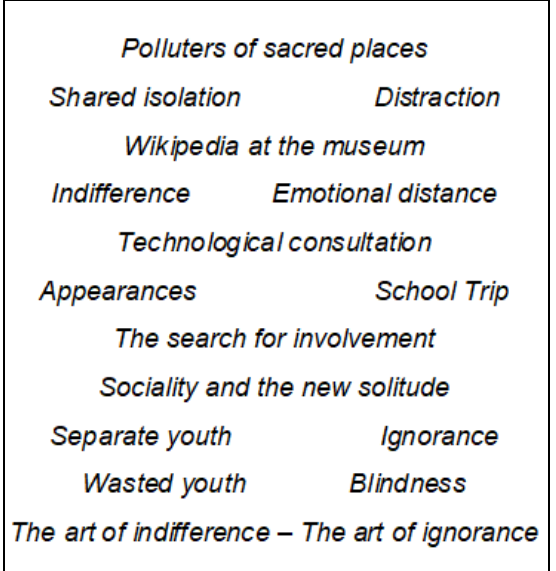
Figure 2: Categories of Proposed Titles